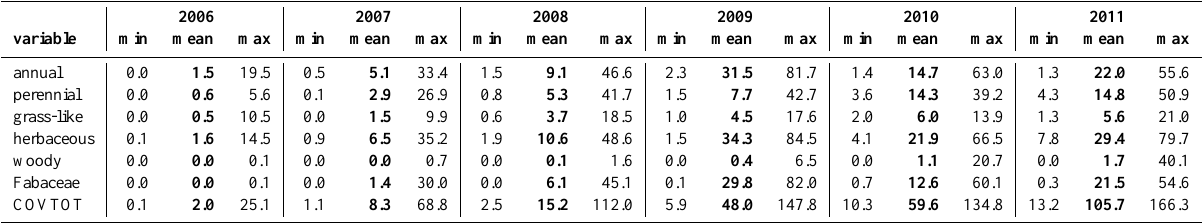
Table 3. Minimum, mean and maximum covers in % per plant species group and year of survey. The allocation of the single plant species to the groups is shown in Table 14. COVTOT is the total degree of coverage by plants (see Table 1). This variable has larger values than the cover sum of annual and perennial, or grass-like, herbaceous, and woody plants, because it also includes the